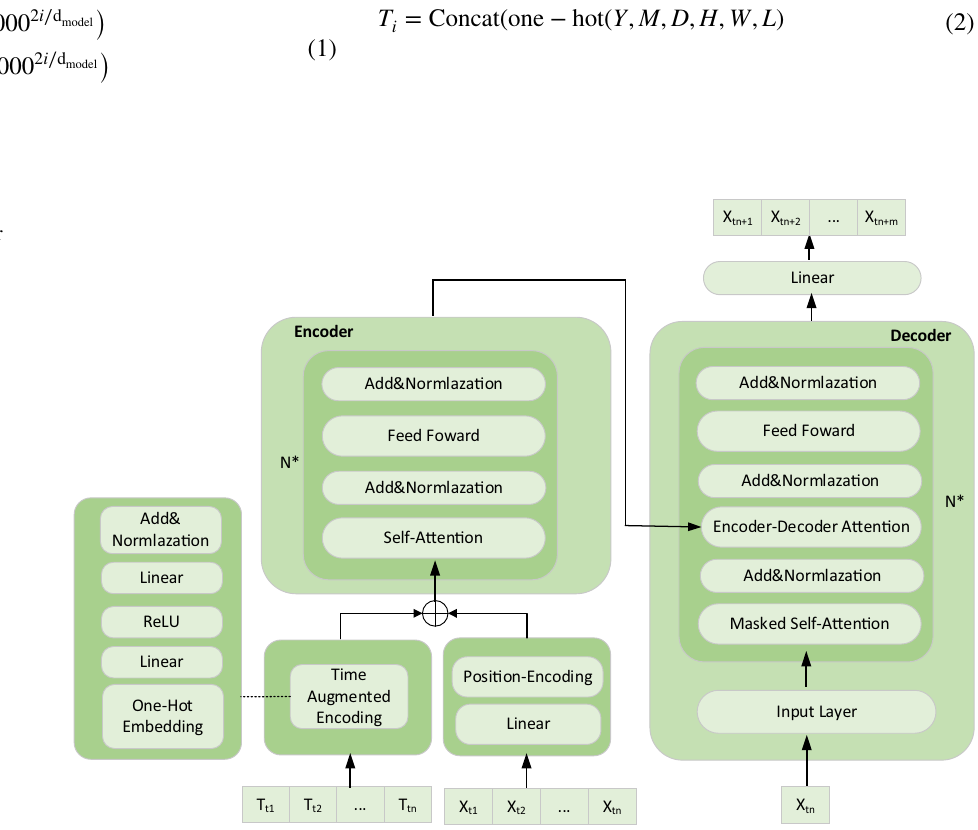
Fig. 2 Structure of Time Aug- mented Transformer model for load